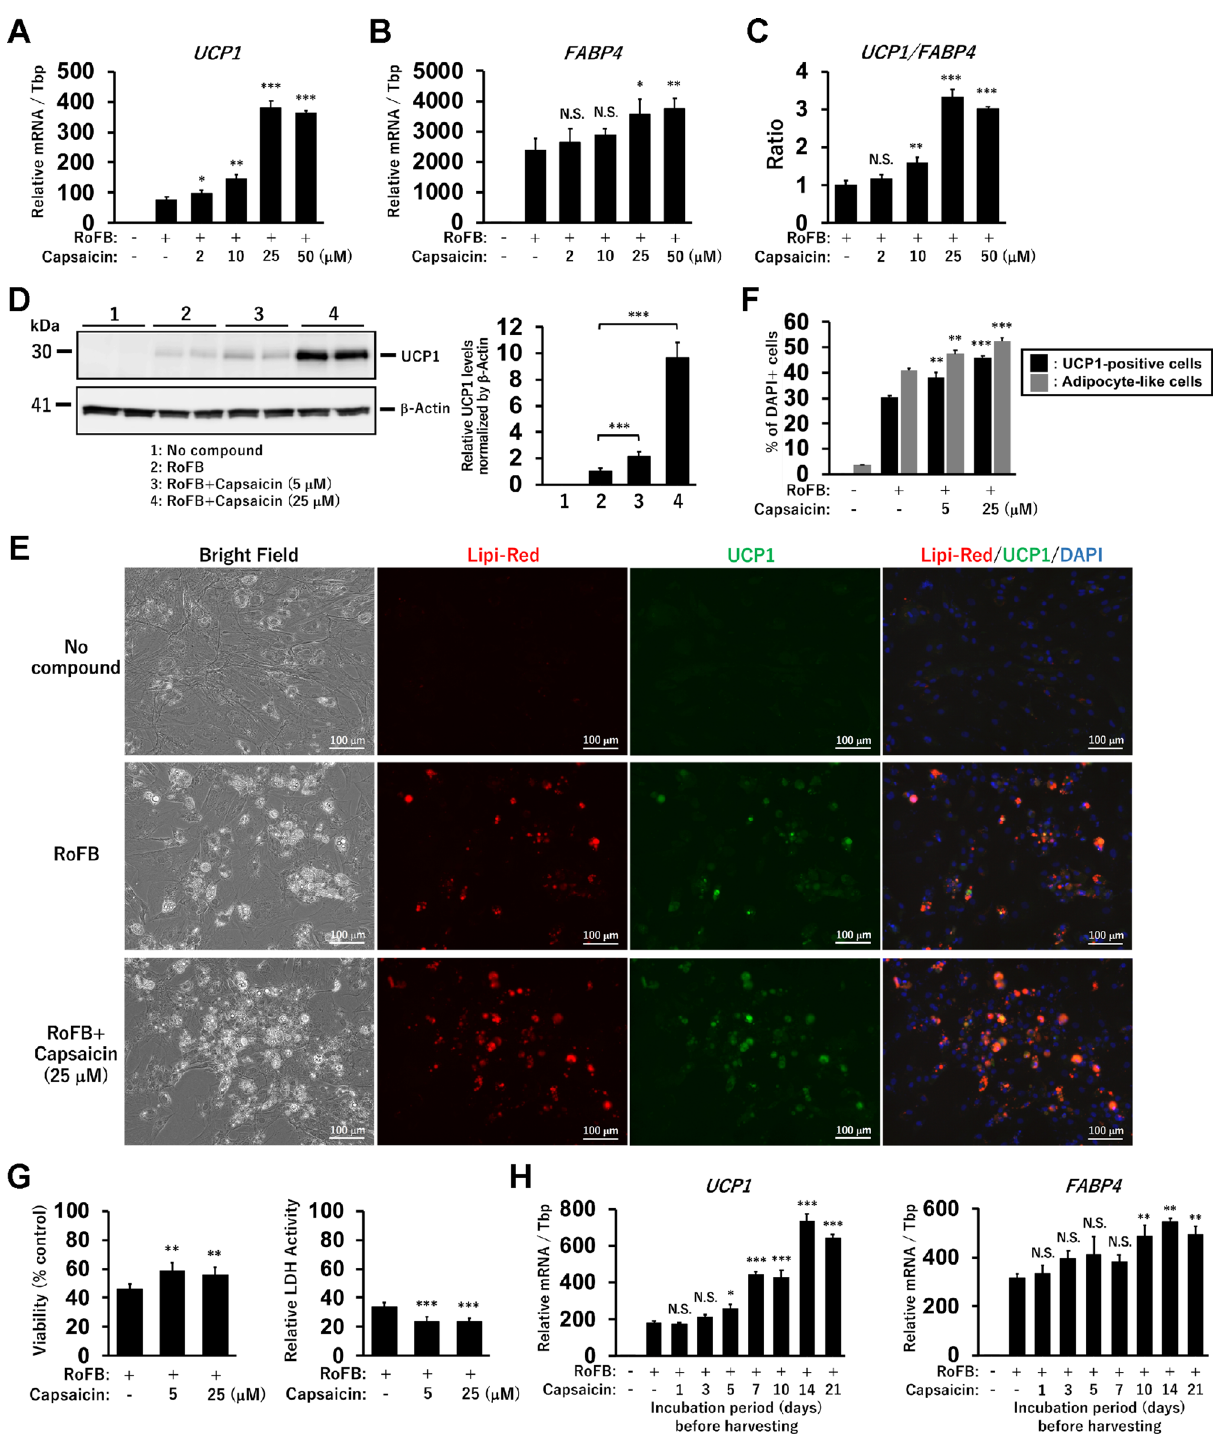
Figure 1. Capsaicin enhances UCP1 expression in ciBAs. ( A,B ) The expression of UCP1 ( A ) and FABP4 ( B ) was quantified by qRT- PCR analysis in ciBAs induced in the presence of Capsaicin at different concentrations as indicated. ( C ) Adipocyte browning activated by Capsaicin was evaluated by the ratio of UCP1 to FABP4 expression. ( D ) UCP1 protein was detected by immunoblotting analysis. The band intensities were quantified by densitometry using ImageJ software. β-Actin was used as a loading control for normalisation. ( E ) Representative images of bright field, Lipi-Red staining (red), UCP1 expression (green), and merged image in the control cells, ciBAs, and Capsaicin-treated ciBAs at 25 μM. The nuclei were visualised by DAPI (blue). Scale bars represent 100 μm. ( F ) To evaluate the conversion efficiency, the percent ratio of adipocyte-like cells with lipid droplets and UCP1-positive cells were calculated. ( G ) Cell viability was measured by the WST-8 regent in ciBAs and Capsaicin-treated ciBAs at 5 μM and 25 μM for 3 weeks. Cytotoxicity was assessed by measuring lactate dehydrogenase (LDH) activity in the culture supernatants. ( H ) The expression of UCP1 and FABP4 was measured in ciBAs treated with Capsaicin at 25 μM for different incubation periods (days) before harvesting the cells on Day 21 for subsequent qRT-PCR analysis. Data represent mean ± SD (n = 3). Student’s t -test: * P < 0.05, ** P < 0.01, *** P < 0.001, N.S.; not